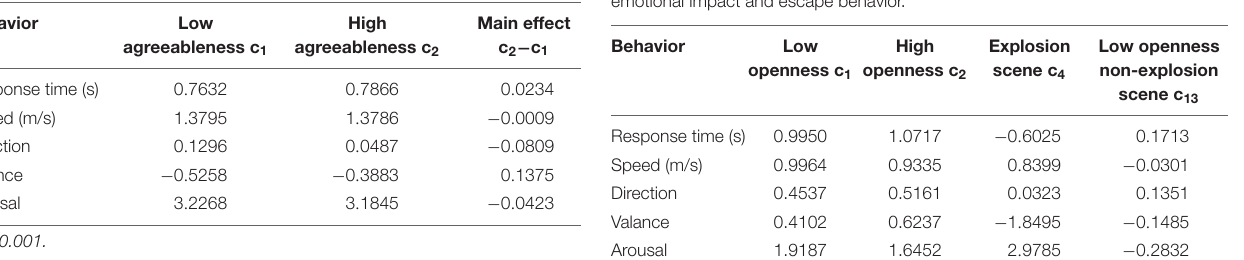
TABLE 6 | The main effect of agreeableness on escape behavior.